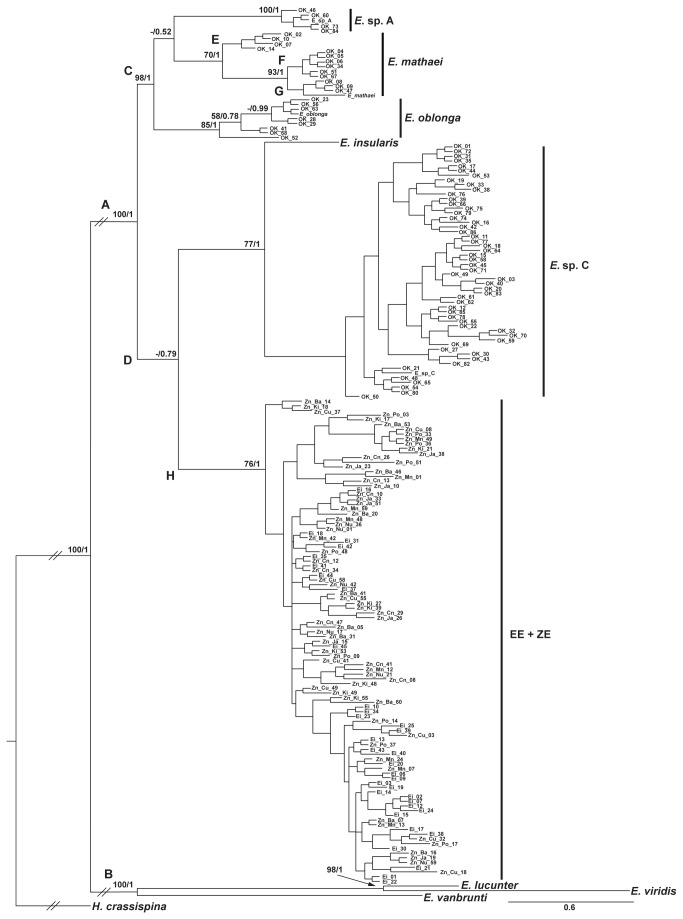

Echinometra Bayesian inference phylogenetic reconstruction tree.Consensus tree of 170,000 trees (after burn-in) generated by MCMC analysis of 20 million generations. 544 bp long COI fragments of 189 Echinometra specimens were used in the analysis. 181 sequences were generated in the current study corresponding to five Echinometra species, and a novel Echinometra mitochondrial lineage. Sequences downloaded from GenBank represent the eight known species of Echinometra and are denoted E. sp. A, E. mathaei, E. sp. C and E. oblonga, E. insularis, E. lucunter, E. viridis and E. vanbrunti (accession numbers: AY262861, AY262940, AY262932, AY262886, AY262906; AF255471, AF255530 and AF255526, from Landry et al. [4] and McCartney et al. [7], respectively). Heliocidaris crassispina (Echinodermata, Echinoidea) (GenBank accession number: JN716400) was used as outgroup. The supporting > 50% values of 1,000 bootstrap replications of the ML analysis and the posterior probabilities of the BI analysis are shown above nodes respectively. Clades A-H are discussed in the text.